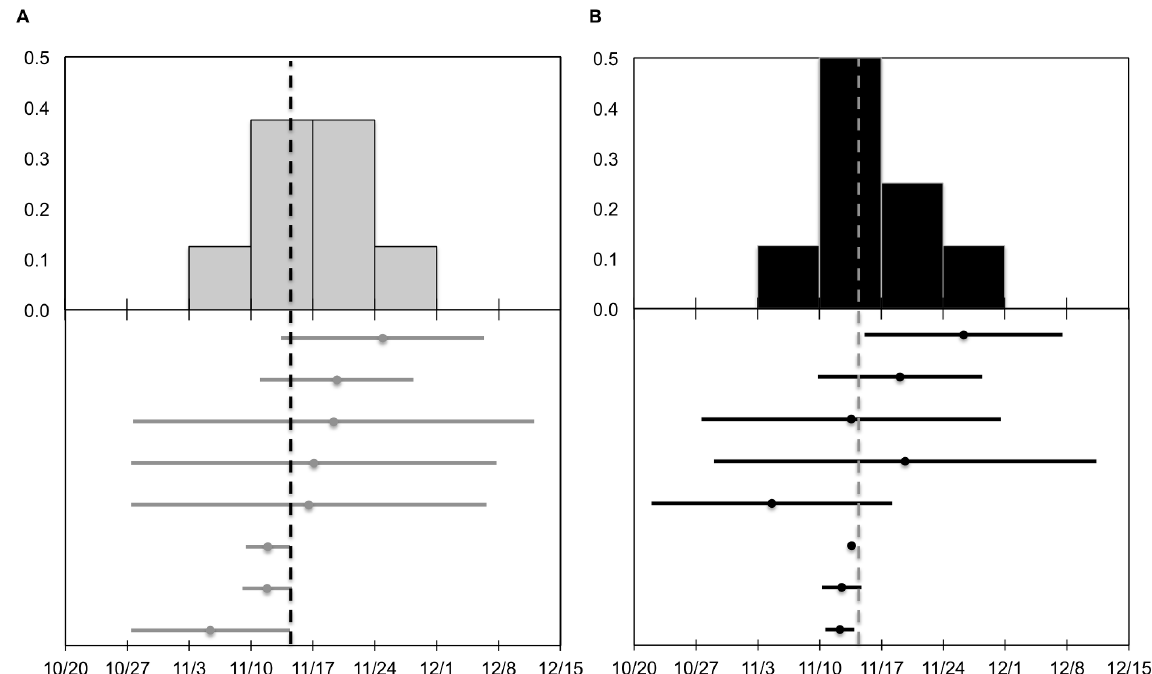
Figure 2. The midpoint and duration of migration in autumn 2010 for eight adult mallard hens. Upper panes illustrate the frequency distribution for the midpoint of autumn migration according to (a) geopolitical method and (b) ND approach. Lower panes illustrate corresponding migration midpoints (circles) and extents (bars) for each of the methods. Vertical dashed lines represent the mean migration midpoint.